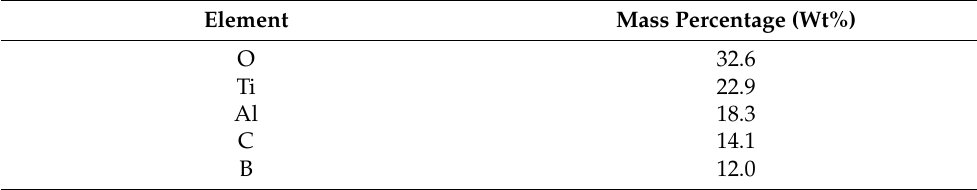
Table 4. Mass percentage of each element in the energy spectrum analysis in Figure